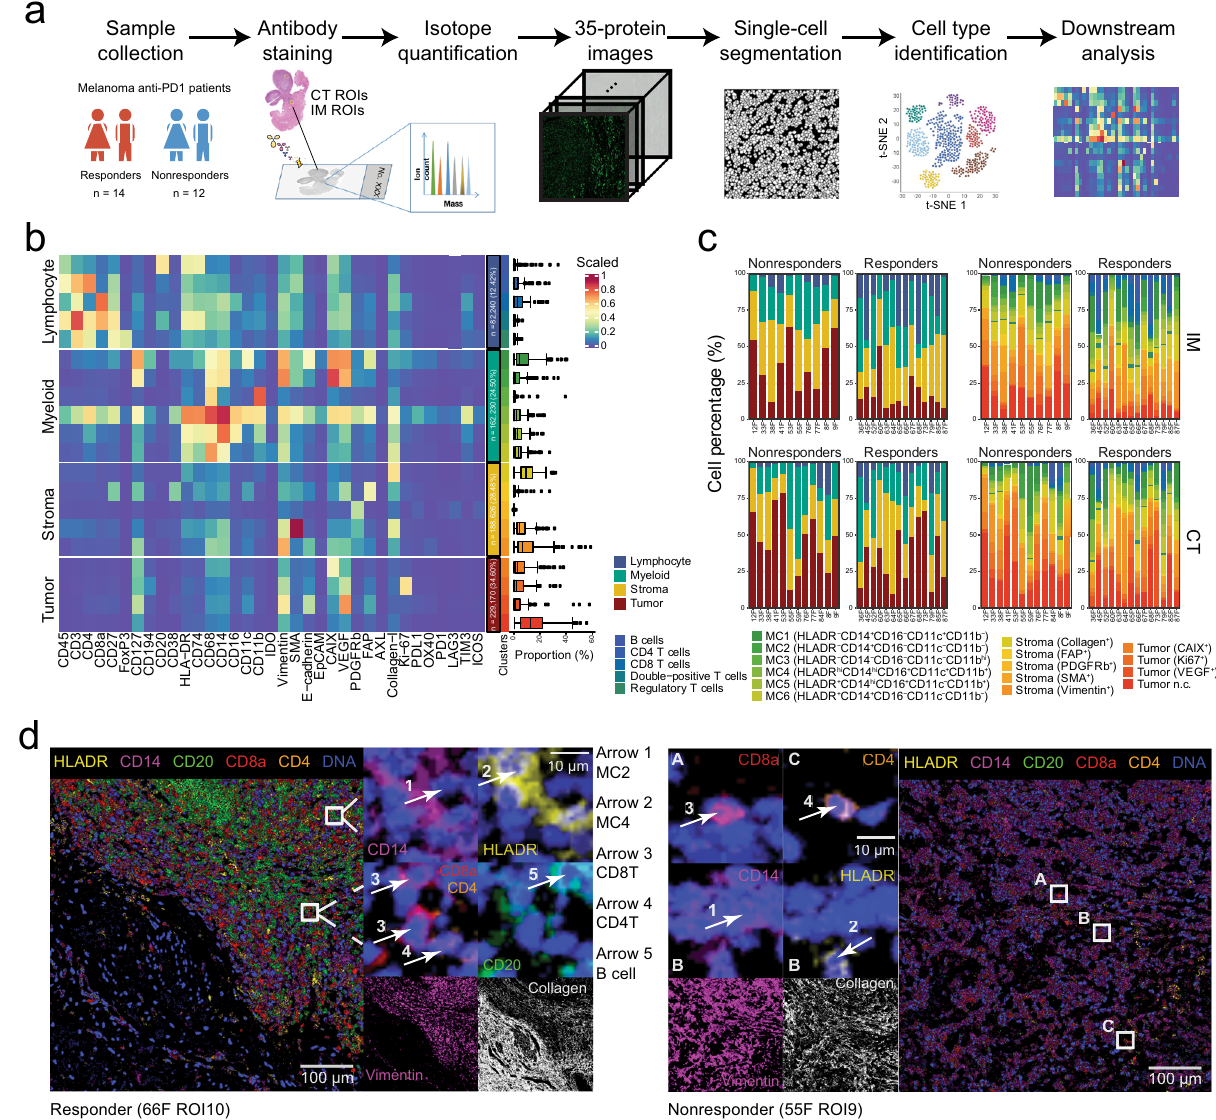
Fig. 1 Overview of the study of melanoma patients using imaging mass cytometry (IMC) and characteristics of cell composition in tumor microenvironments. a Work fl ow of IMC images acquisition from melanoma patients and data analyses. b Heatmap of mean values of scaled protein expression per cell type identi fi ed by unsupervised clustering (FlowSOM and Phenograph) for a total of 662,266 single cells. The boxplots on the right depicting the cell proportion of each IMC image. Each boxplot is shown with the median (the center line), interquartile range (IQR), and 1.5 times the IQR (whiskers), with outliers exceeding 1.5 times the IQR ( n = 158 images). c Stack bars showing averaged cell percentage in images in the invasive margin (IM, top) and core tumor (CT, bottom) from responders and nonresponders, colored by four main cell types (left) and 20 cell subtypes (right). d Representative multichannel IMC images (ROI: region of interest) from one responder (left) and one nonresponder (right). Vimentin (magenta) and collagen I (white) were used to portrait the structure of the tissue. with elevated macrophage marker CD68. The second category was comprised of HLA-DR − subtypes with elevated expression of exhaustion markers CAIX and VEGF (MC2, MC3) or indoleamine 2,3-dioxygenase 1 (IDO-1; MC1), representing their potential immune-suppressive roles as myeloid-derived suppressor cells (MDSCs). Stromal cells consisted of fi ve subtypes denoted as S1 to S5 for Collagen + , FAP + , PDGFRb + , SMA + , and Vimentin + cells, Shannon entropy analysis indicated more diversi fi ed cell-type respectively, and tumor cells included 4 subtypes denoted as T1 to compositions in responders than in nonresponders in the IM, but T4 for CAIX + , Ki67 + , VEGF + , and a non-classi fi ed subtype (n.c.) not in the CT. Two IMC images to exemplify TMEs with typical that did not show the elevated expression on any markers from the immune cells in a responder and a nonresponder are shown in de fi ned panel, respectively. Fig. 1d.